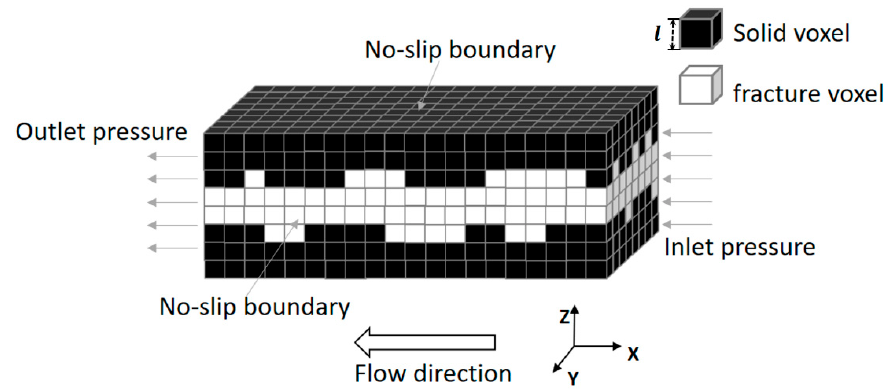
Figure 5. LBM computing domain.